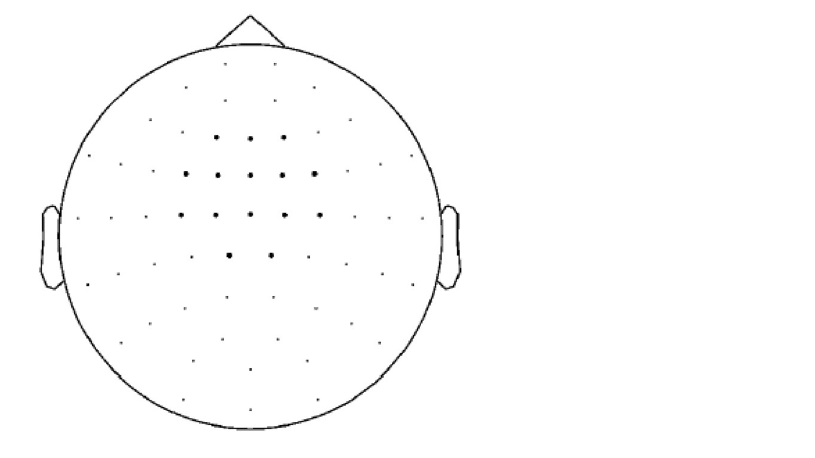
Figure 1. The highlighted dots represent the topographical distribution of the selected 15 fronto-central channels used for the statistical analysis of mERN amplitudes in both